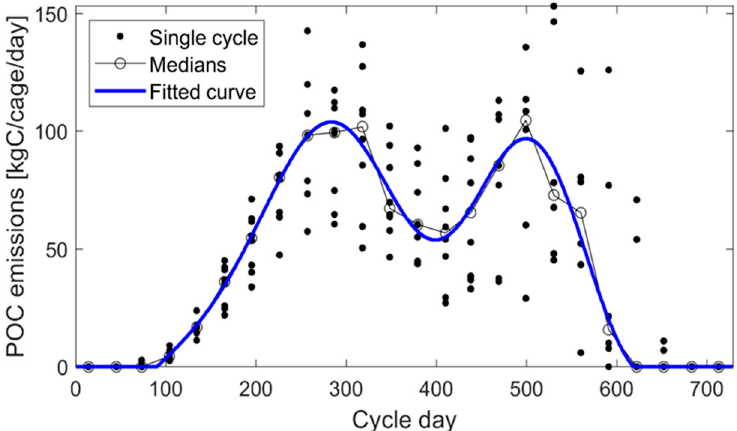
Figure 3. Modeled fish farm emissions (blue line) in the form of Particulate Organic Carbon fluxes over a typical two-year production cycle, also showing the source data from 2 fish farms in Hardangerfjord over several production cycles (filled dots) and the monthly median values (open circles) to which the model curve was fitted.